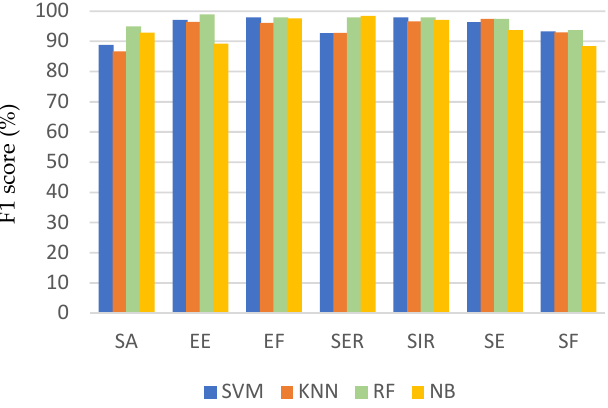
Figure 7. Precision for each activity using different classification algorithms.